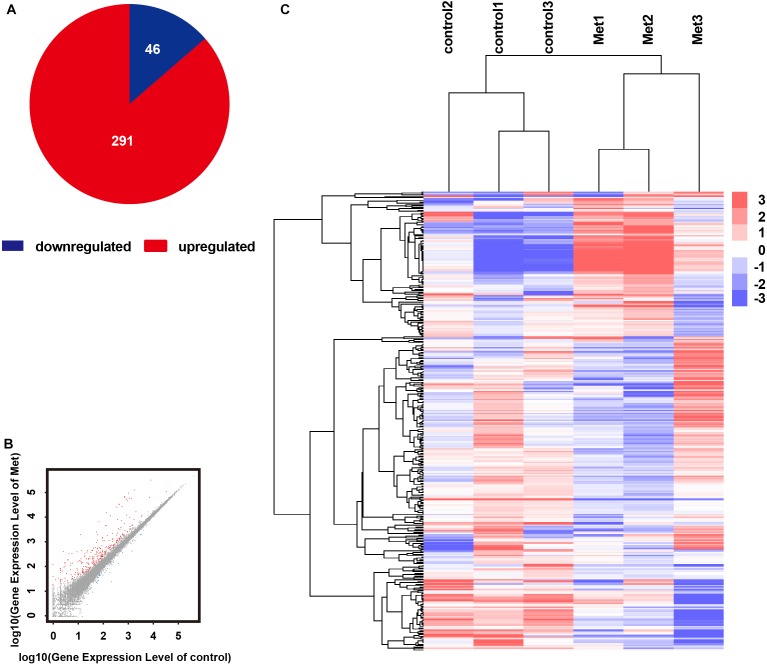
RNA sequencing results showing that metformin affected gene expression in the rd1 mice retina at P14. (A) Pie chart of all differentially expressed genes. red: gene upregulated by metformin; blue: gene downregulated by metformin. (B) Scatterplots showing all expressed genes as the control group expression level vs. the metformin-treated group expression level. red: gene upregulated by metformin; blue: gene downregulated by metformin; gray: gene not regulated by metformin. (C) Hierarchical clustering of differentially expressed genes in the control and metformin treatment groups. Red: high relative expression; blue: low relative expression. P-values and Q-values (MA-plot) represent the significance of the differences (fold change ≥ 2 and adjusted P-value ≤ 0.001).